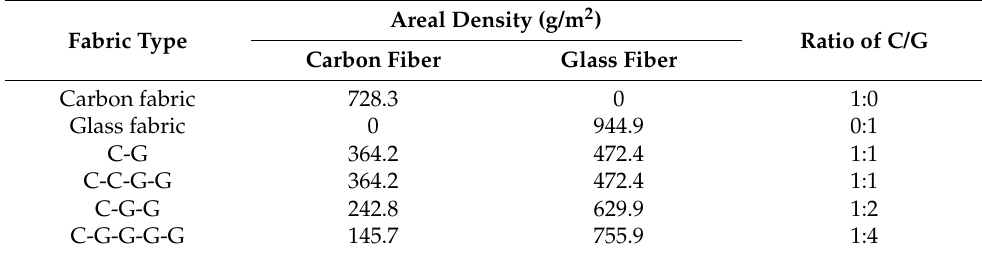
Table 2. Specifications for hybrid